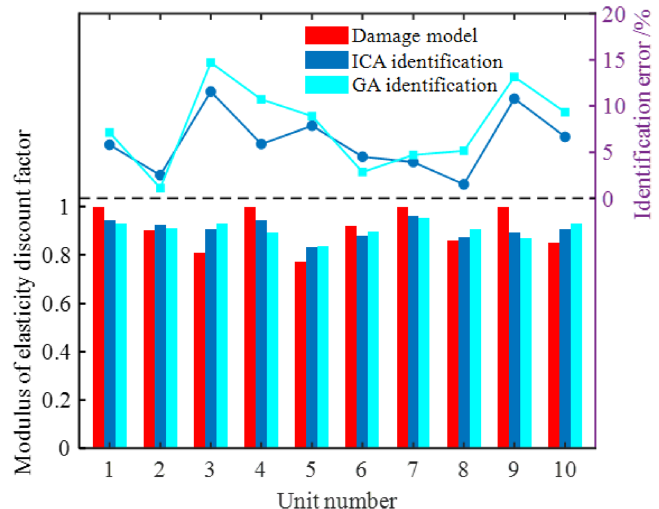
Figure 6. Comparison chart: